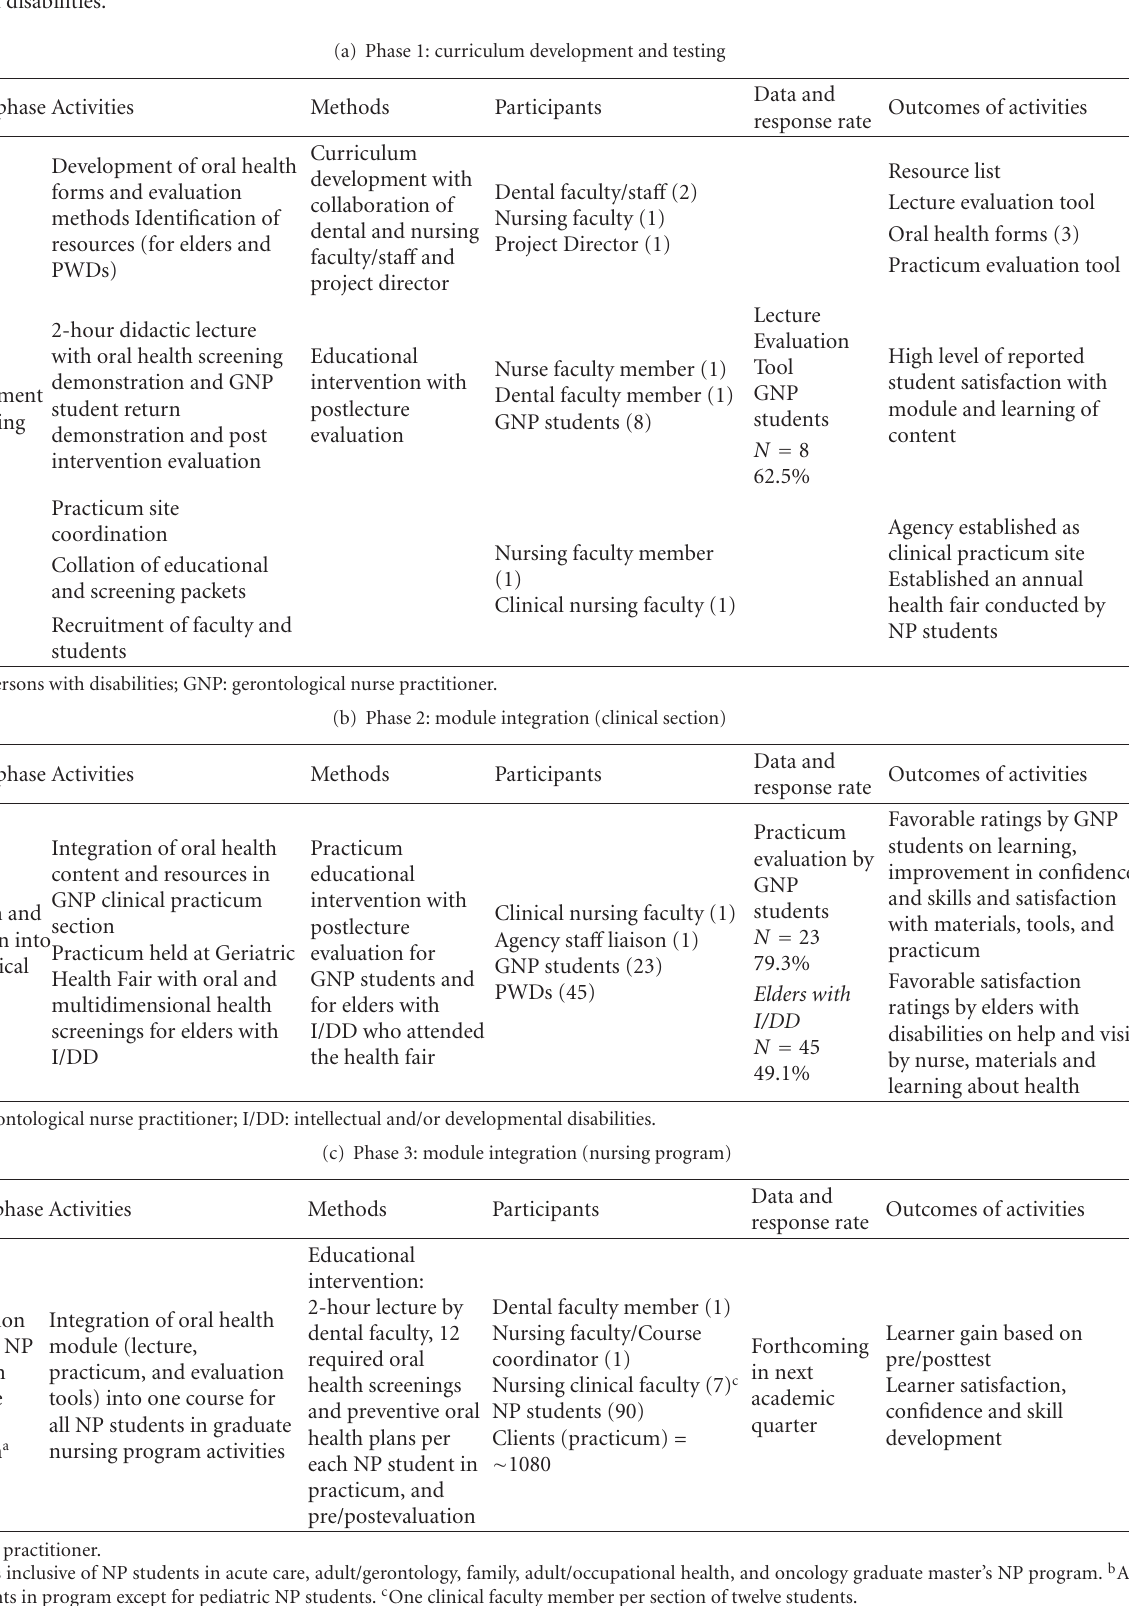
Table 1: Overview of phases of development, testing and integration of an oral health module for nurse practitioner students serving persons aging with